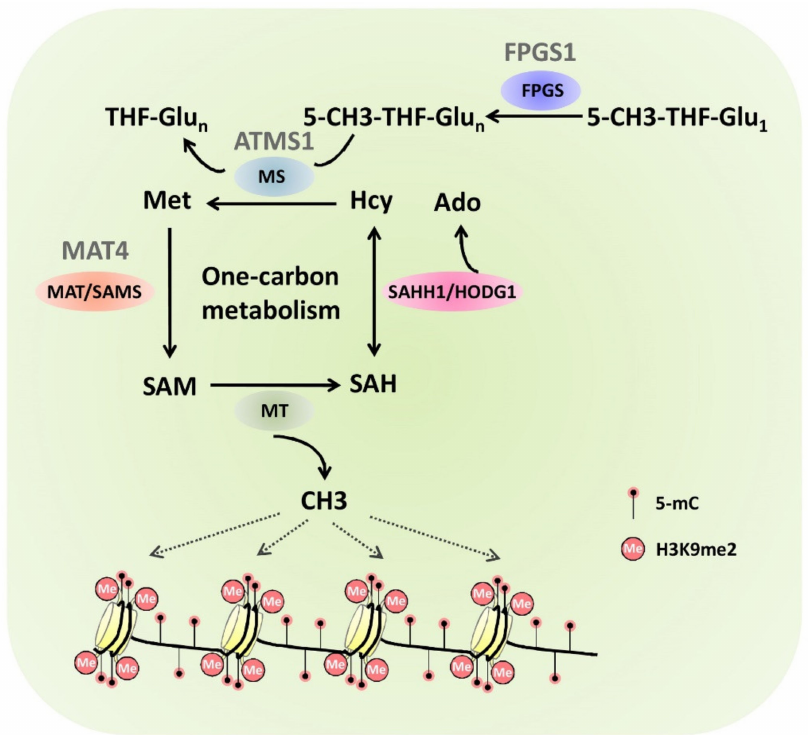
Figure 4. Simplified models for one-carbon metabolism pathway contributing to the DNA and histone methylation by producing the methyl group donor